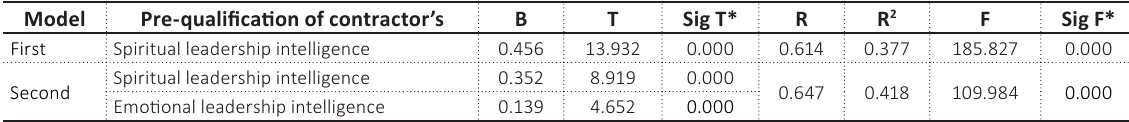
Table 3. Stepwise regression for H01 Model